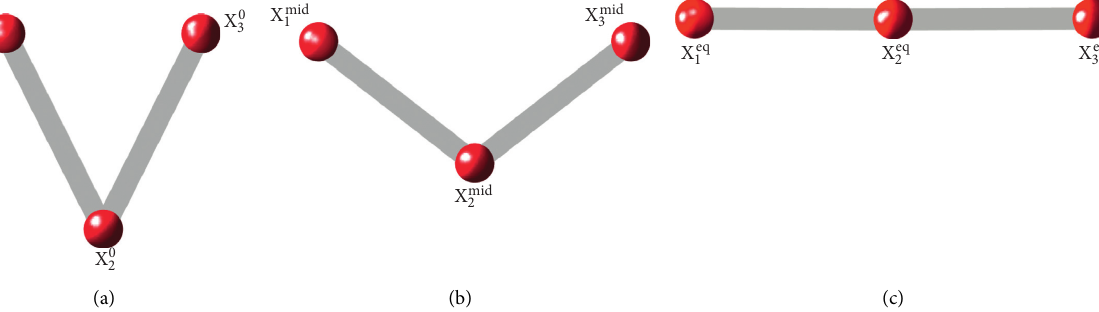
| X n − X n | < d ij and (b) attractive force i j